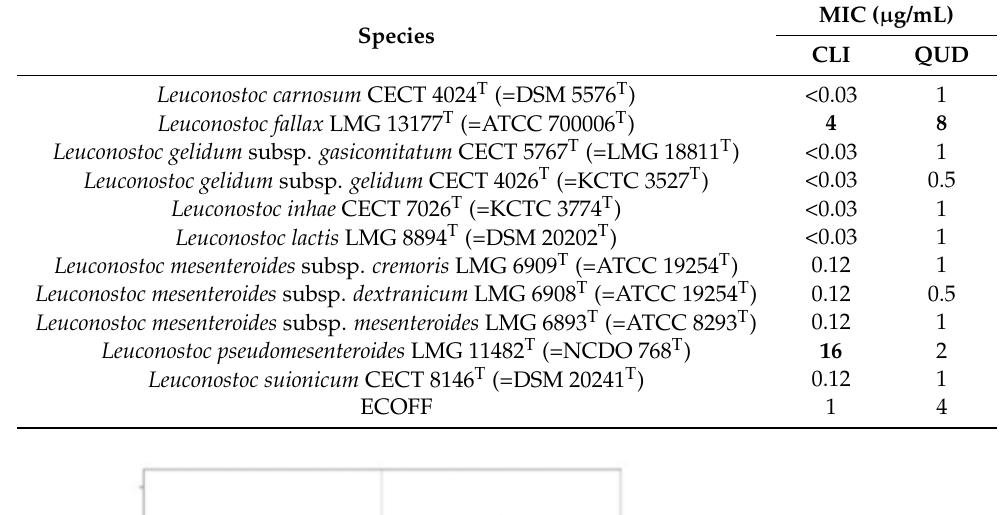
Table 2. Minimum inhibitory concentration (MIC) values for clindamycin (CLI) and quinupristin- dalfopristin (QUD) of 11 type strains determined through the broth microdilution method. MICs higher than the Epidemiological cut-off (ECOFF) values are reported in bold.